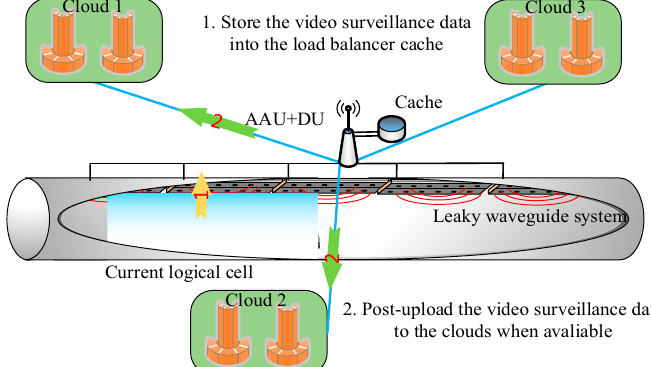
Figure 12. The diagram of the post-uploading scheme.